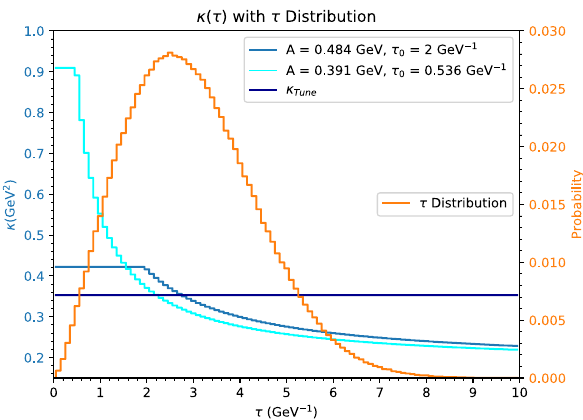
Fig. 1 Modifiedstringtension κ(τ) comparedtoconstanttension κ tune with τ distribution for different definitions of τ 0 and